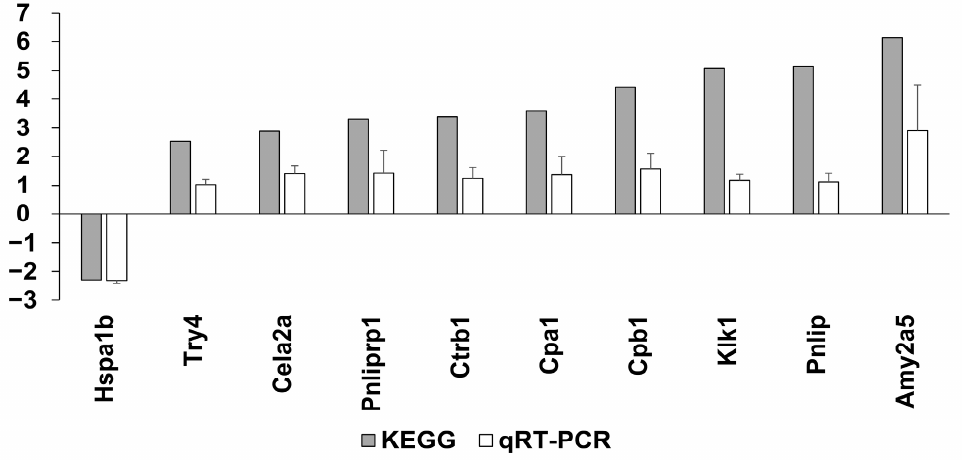
Figure 6. Validation of differentially expressed genes (DEGs) using qRT-PCR. Error bars represent 2 standard errors (SE).